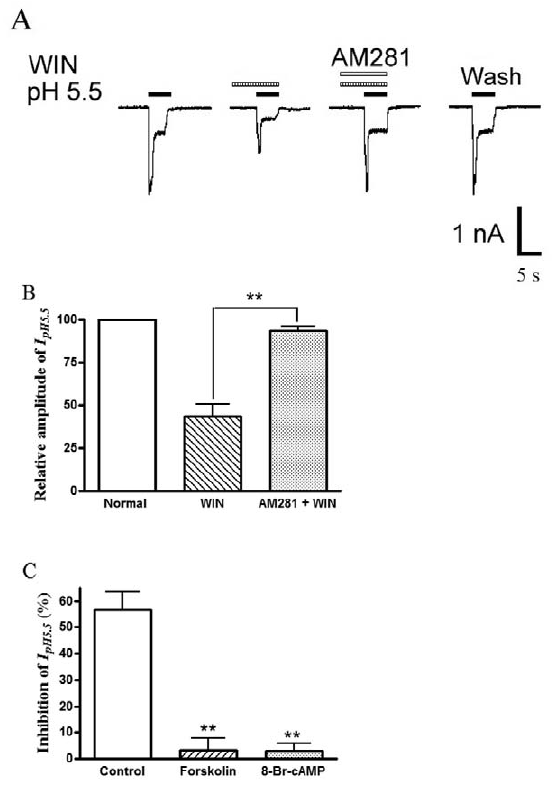
Figure 5. The receptor and intracellular signal transduction mechanisms underling inhibition of proton-gated currents by WIN55,212-2. The current traces in (A) and the bar graph in (B) show that the inhibition of I pH5.5 by WIN55,212-2 (WIN, 10 2 7 M) pre-applied alone was abolished by the co-application of WIN55,212-2 and AM281 (10 2 6 M), a selective CB1 receptor antagonist ** P , 0.01, one way analysis of variance followed by post hoc Bonferroni’s test, n=8. The bar graph in (C) shows the percentage decreases in the I pH5.5 induced by WIN55,212-2 (10 2 7 M) in control and pre-treatment of forskolin and 8- Br-cAMP conditions. The inhibition of WIN55,212-2 on proton-gated current was blocked by application of forskolin (10 2 5 M) or 8-Br- cAMP(10 2 3 M). **P , 0.01, one way analysis of variance followed by post hoc Bonferroni’s test, compared with control, n=7/each column.